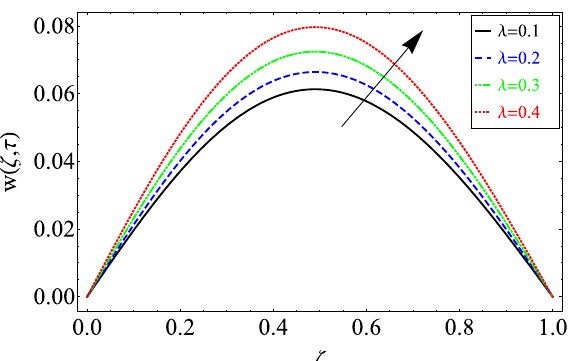
Figure 3. The effect of different values of (cid:31) on velocity distribution of Maxwell nanofluid, when Re = 10 , α = 0.7 , τ = 0.5 , φ = 0.02 , Gr = 0.05 , Pr = 6300 , Sc = 15 and Gm = 0.5 .